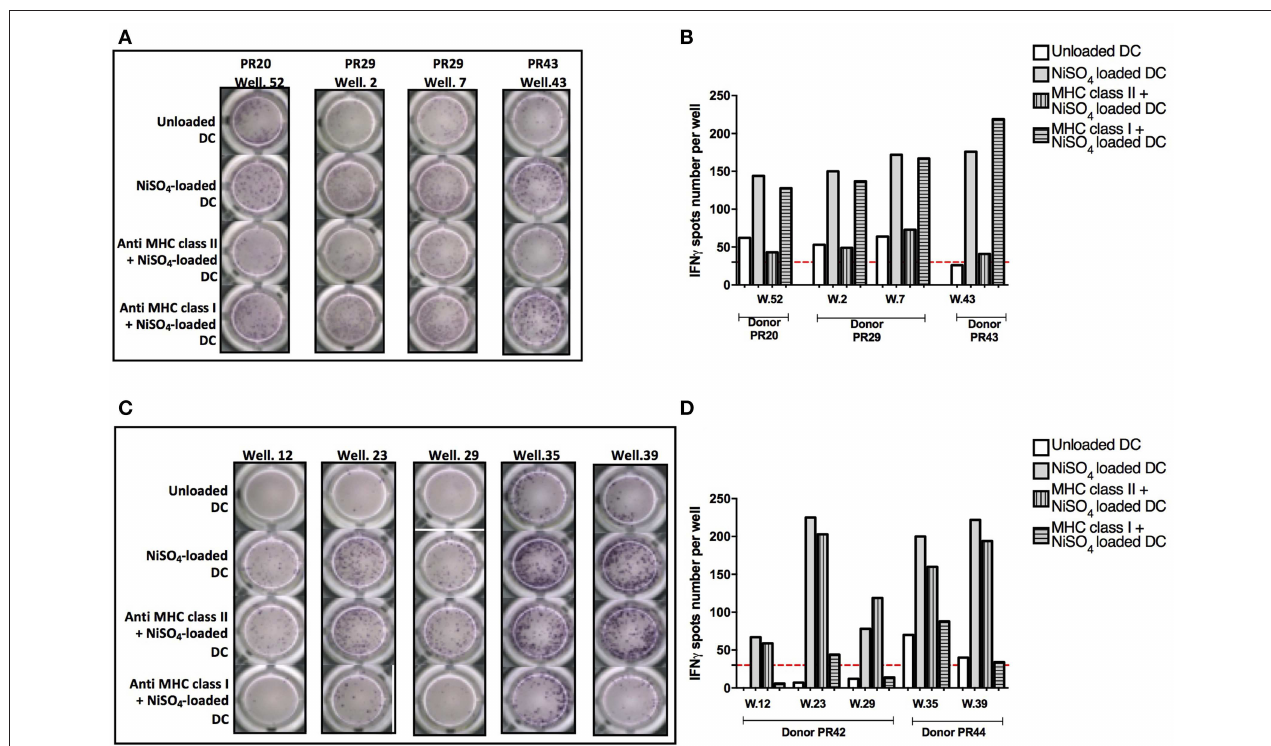
FIGURE 4 | Implication of MHC class II and I molecules in nickel-specific T-cell response. (A) IFN- γ ELISpot response for naïve CD4 + T cells from donors PR20, PR29, and PR43 stimulated with unloaded DC or DC loaded with NiSO 4 or DC loaded with MHC blocking antibodies prior to nickel treatment. (B) Spots count for naïve CD4 + T cells specific to nickel from donors PR20, PR29, and PR43 stimulated with unloaded DC or DC loaded with NiSO 4 or DC loaded with MHC blocking antibodies prior to nickel treatment. Dashed line represents the minimum required spots count (count = 30) for the analysis to be considered acceptable. (C) IFN- γ ELISpot response of naïve CD8 + T cells from donors PR42 and PR44 stimulated with unloaded DC or DC loaded with NiSO 4 or DC loaded with MHC blocking antibodies prior to nickel treatment. (D) Spots count for naïve CD8 + T cells specific for nickel from donors PR42 and PR44 stimulated with unloaded DC or DC loaded with NiSO 4 or DC loaded with MHC blocking antibodies prior to nickel treatment. Dashed line represents the minimum required spots count (count = 30) for the analysis to be considered